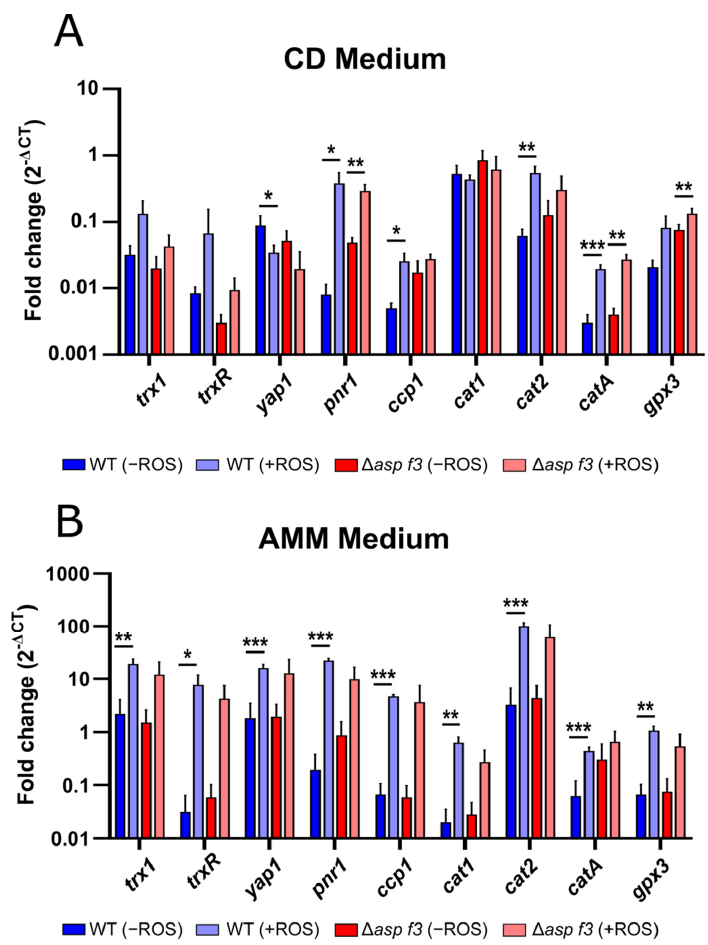
Figure 5. Gene expression of ROS defense genes in wild type (WT) and aspf3 -deleted ( ∆ asp f3 ) hyphae of Aspergillus fumigatus in Czapek Dox ( A ) and Aspergillus minimal medium ( B ) in the absence ( − ROS) or presence (+ROS) oxidative stress. Data from qRT-PCR are displayed as logFC normalized to the housekeeping gene tubA and represent the mean and SD of three biological replicates. For statistical analysis, Student’s t-test with *: p < 0.1; **: p < 0.05; ***: p < 0.01 was